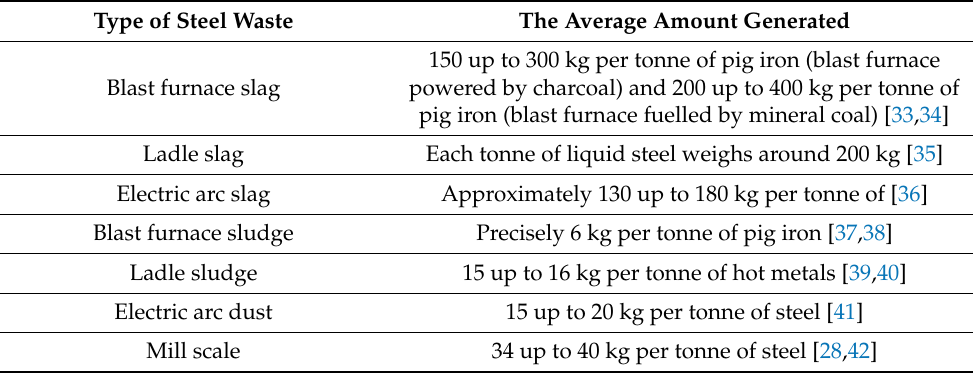
Table 2. The average of steel waste generated from steelmaking production